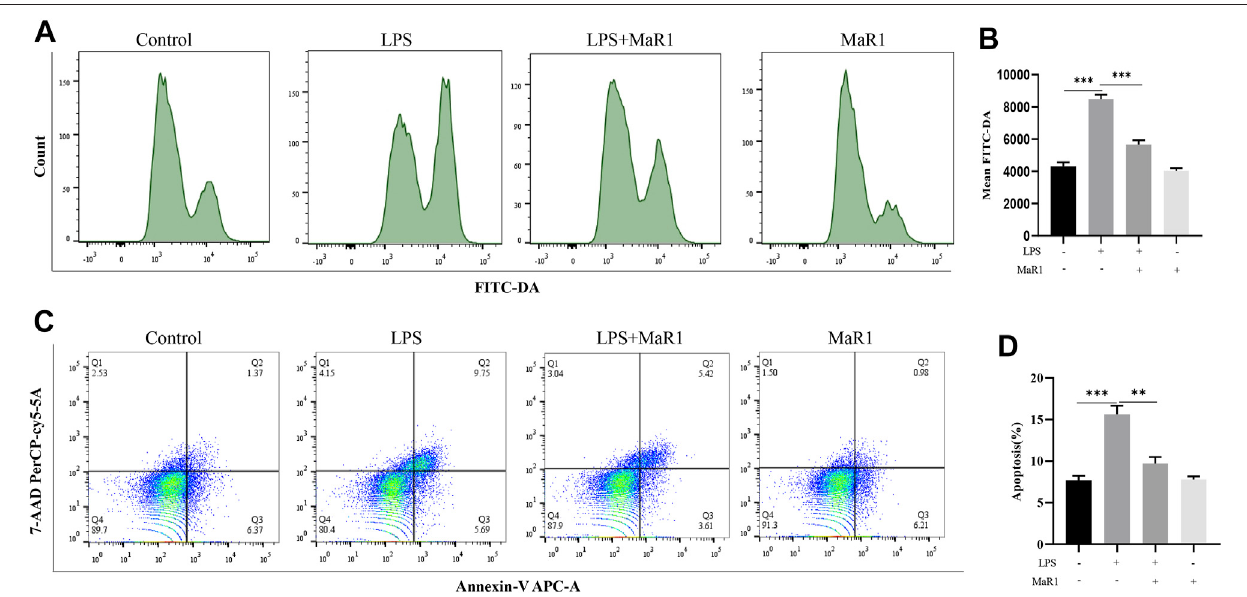
FIGURE 7 | MaR1 inhibited ferroptosis by inhibiting ROS production in vitro . (A,B) The fl ow cytometry showed that LPS signi fi cantly promoted the production of ROS, while MaR1 signi fi cantly reduced the ROS production. (C,D) MaR1 inhibited LPS-induced apoptosis at 24 h. Data are shown as the mean ± SD, * p < 0.05; ** p < 0.01; *** p <